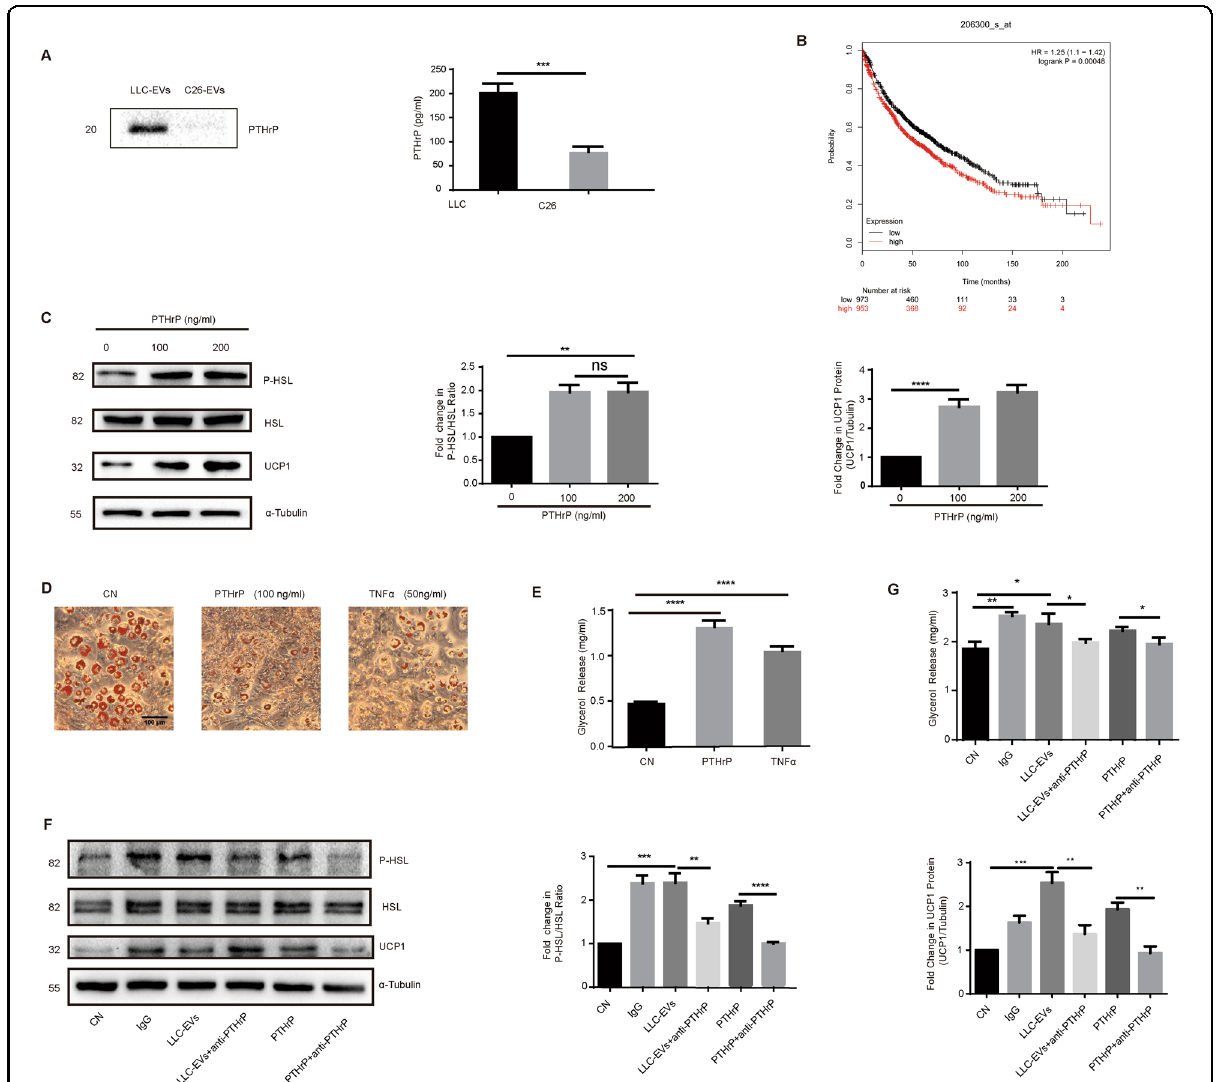
Fig. 3 PTHrP in LLC-EVs participated in lipolysis in 3T3-L1 adipocytes. A Western blotting showing the presence of PTHrP in LLC-EVs (50 μ g) but not clearly in C26-EVs (50 μ g) (there is no appropriate internal control in extracellular vesicles. Therefore, we detected the expression of UCP1 from the same quantity of protein sample loaded); The concentrations of PTHrP in the supernatants from LLC and C26 cultures. Data ( n = 4) were analyzed by Student t test. B High expression of PTHrP in a tumor predicts a worse overall survival for patients with lung cancer. C Western blotting showing the relative levels of phospho-HSL: HSL and UCP1 in adipocytes treated with different doses of PTHrP (100 ng/ml and 200 ng/ml). Data ( n = 7) were analyzed by analysis of variance (ANOVA). D Oil red O staining of 3T3-L1 adipocytes cultured with PTHrP (100 ng/ml) or TNF- α (50 ng/ml). Bar = 100 µm. E The levels of glycerol release in 3T3-L1 adipocytes treated with LLC-EVs(10 μ g) or TNF- α for 24 h. Data ( n = 3) were analyzed by analysis of variance (ANOVA). F Western blotting showing the relative levels of phospho-HSL and HSL in 3T3-L1 adipocytes treated with PTHrP (with and without anti-PTHrP) and with LLC-EVs (with and without anti-PTHrP). Data ( n = 3) were analyzed by analysis of variance (ANOVA). G The levels of glycerol release from 3T3-L1 adipocytes treated with PTHrP (with and without anti-PTHrP) and with LLC-EVs (with and without anti-PTHrP) for 24 h. Data ( n = 4) were analyzed by analysis of variance (ANOVA). * P < 0.05, ** P < 0.01, *** P < 0.001, **** P < 0.0001, ns: not signi fi